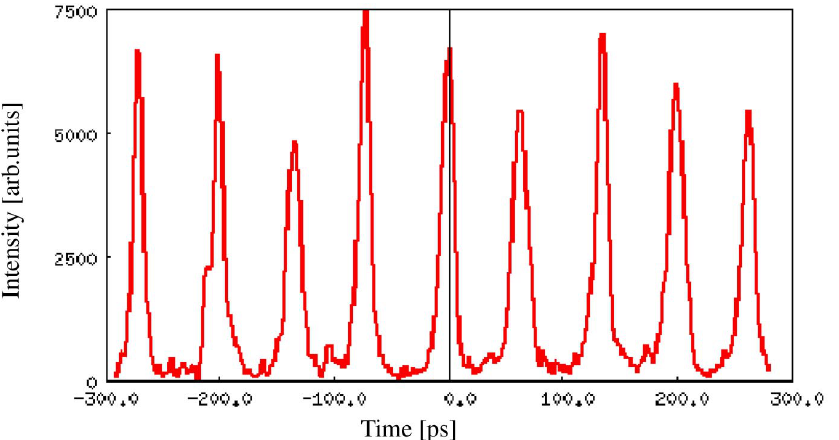
FIG. 22. (Color) Longitudinal intensity profiles for a multiplication factor